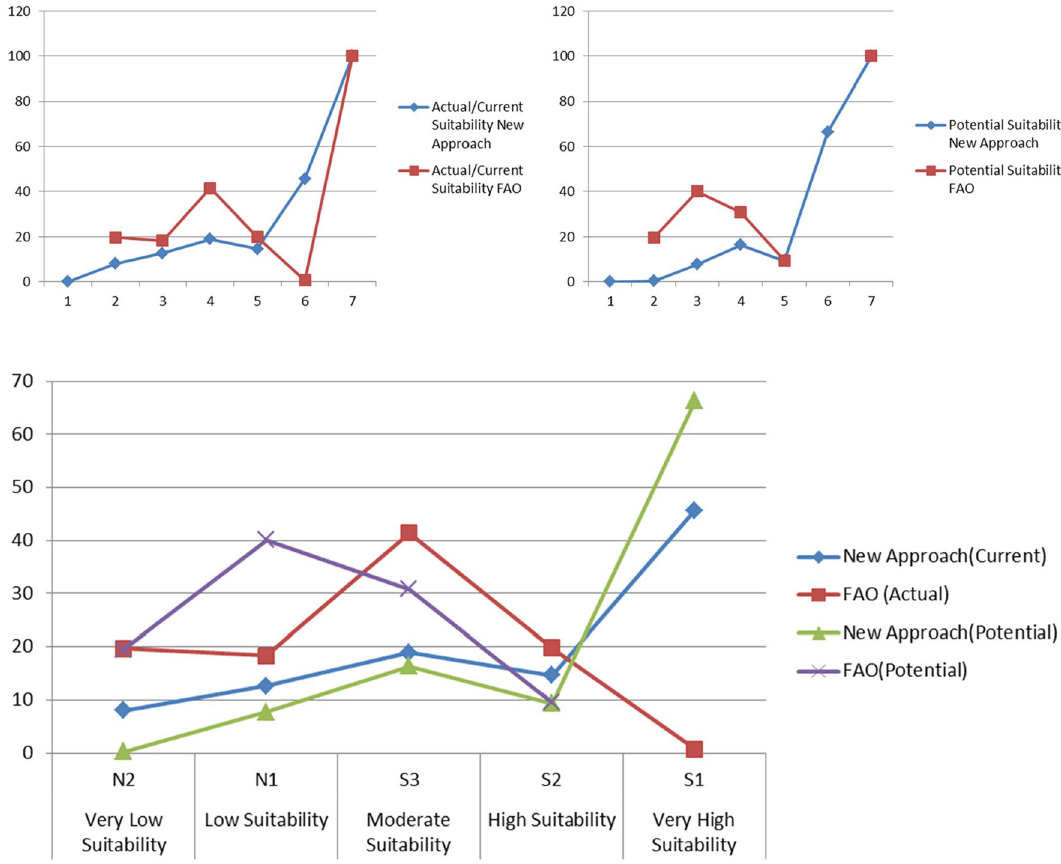
Figure 6. Correlation between FAO and the new suitability